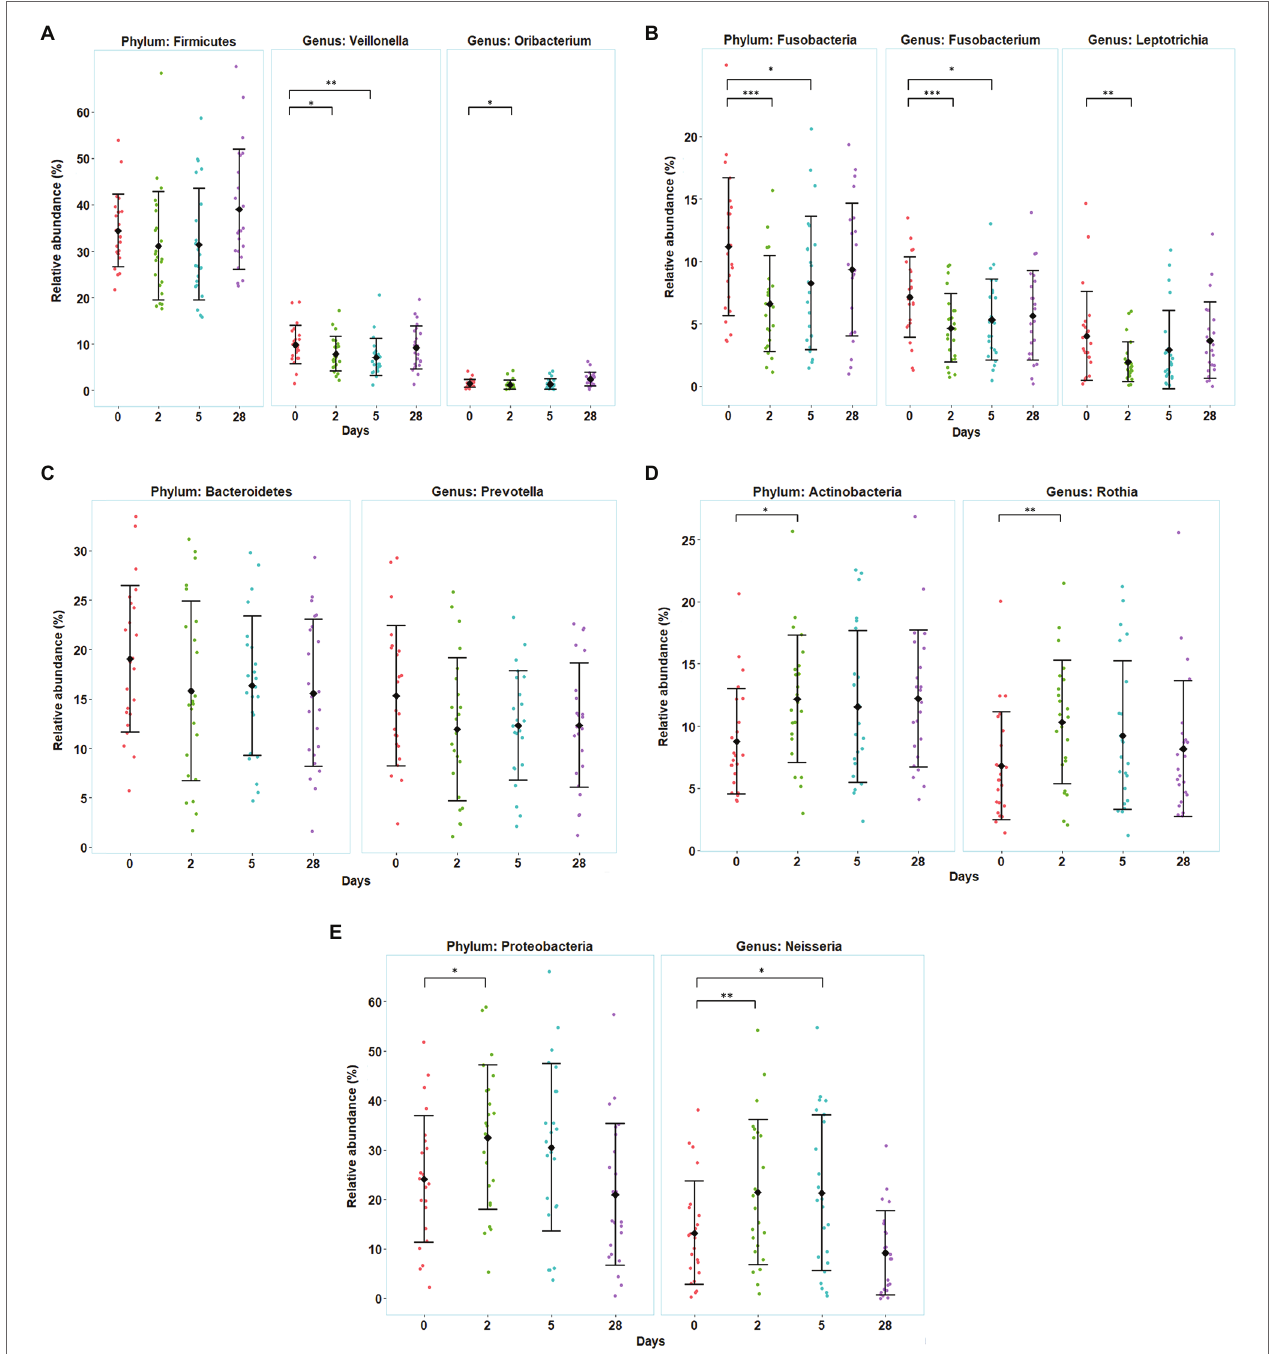
FIGURE 4 | Variation in the divers’ oral microbiota before (day 0), during the bottom phase (days 2 and 5), and after decompression (day 28) from heliox saturation diving. (A–E) Observed shifts in the relative abundance of the five most abundant bacterial phyla, along with their significantly altered genera. For each time-point: mean ( ♦ ) and individual values are shown. Error bars are ±1 SD (* p ≤ 0.05; ** p ≤ 0.01; and *** p ≤ 0.001). The relative abundance is given in percentage of total bacterial